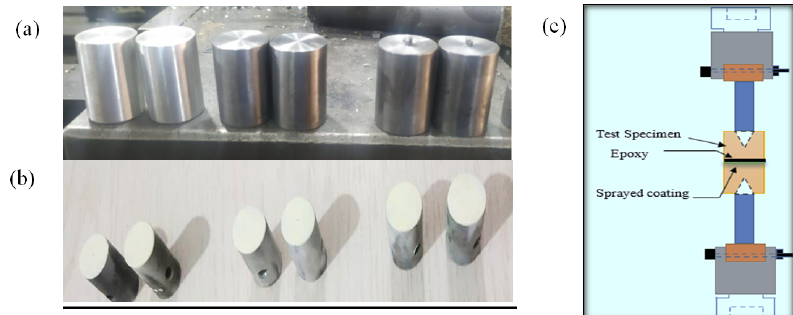
Figure 4: (a) Bond strength samples preparations before coating with Nanox S4007 with different thicknesses, (b) Samples after coating and (c) Adhesion test unit